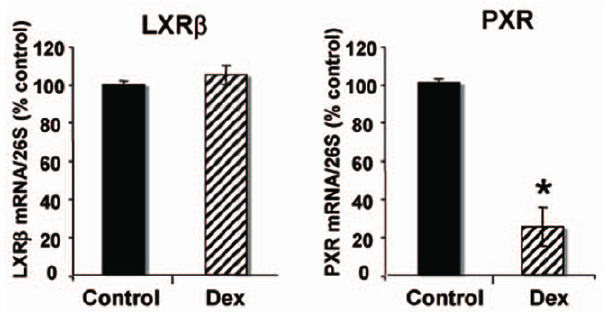
Figure 2. Effect of dexamethasone on the expression of LXR b and PXR. 158N cells were incubated with Dex (1 m M) during 24 h. Total RNA was extracted and real-time PCR experiments were performed using primers recognizing specifically LXR b or PXR. Results are expressed as the ratio of LXR or PXR expression over 26S. 100% is the level in control cells. They represent the mean + / 2 SEM of three independent experiments. *p , 0.05 when compared to control by using Student’s t